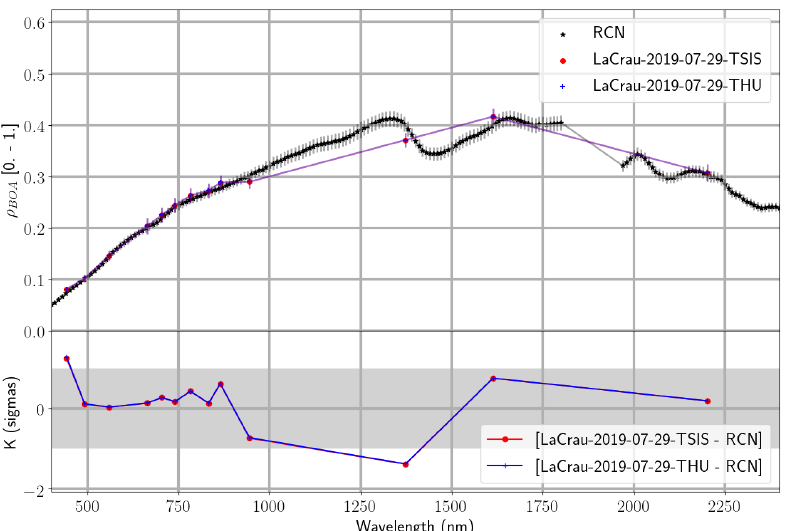
Figure 9. Consistent scenario. Top : L2A surface reflectance of RadCalNet (RCN) (black), PACO L2A with Thuillier 2003 (blue, “+”) and TSIS (red, “.”) solar models. Bottom : Uncertainty ratio (K) between each of L2A surface reflectance with the previous solar models with respect to RadCalNet in situ reference values. Grey band limits ± 1 sigma